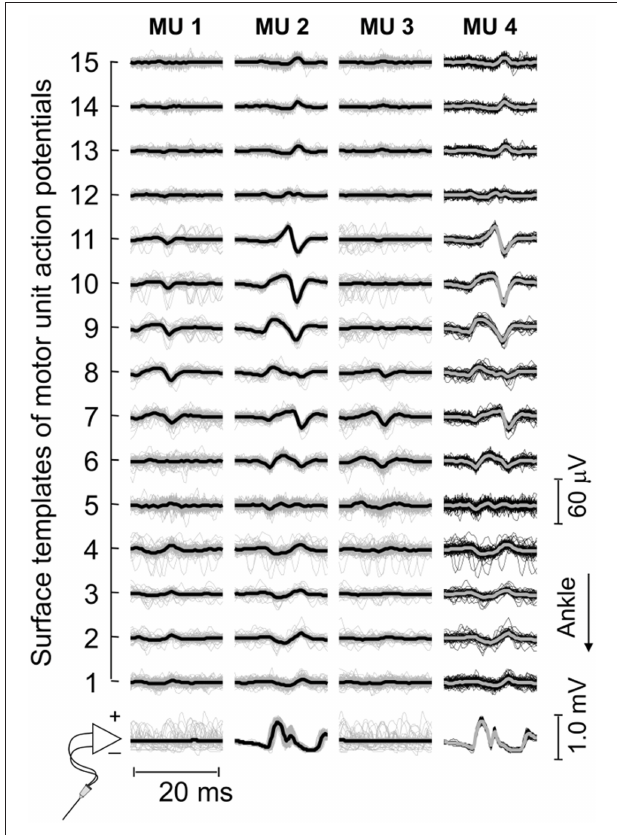
FIGURE 3 | Motor unit action potentials in surface and intramuscular recordings. Short epochs (20ms) of EMGs detected by wire and surface electrodes are shown. These epochs (thin traces) were obtained by triggering EMGs with the firing pattern of individual motor units, separately for each surface and intramuscular recordings. Thick traces were obtained by averaging the triggered EMGs. For this participant, three motor units were identified through decomposition of surface EMGs (cf. the first three columns from left to right). Note the similarity between waveforms obtained for the motor unit (MU 2) identified from decomposition of surface recordings and those obtained for the motor unit (MU 4) identified from decomposition of intramuscular